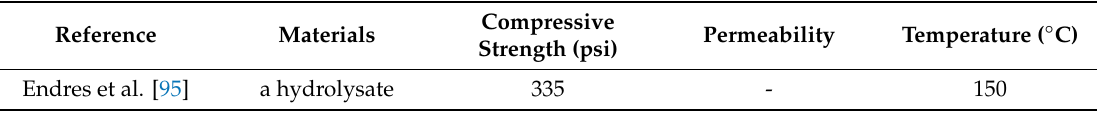
Table 15. Hydrolysate or precondensate consolidation agent method to consolidate sand formation.